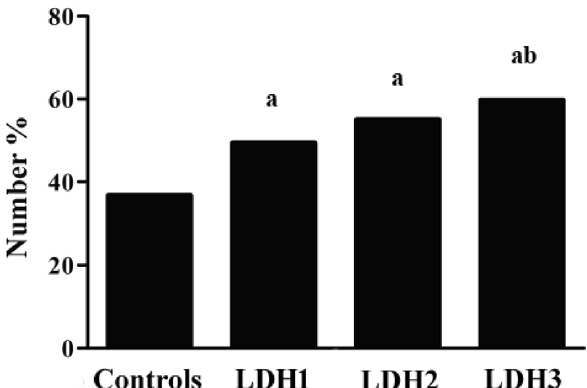
Figure 1. Proportion of endothelial dysfunction in normotensives and hypertensive patients with increasing tertile of LDH level (n = 1507). a p < 0.05 versus normotensives, b p < 0.05 versus hypertensive patients with lowest tertile of LDH level.